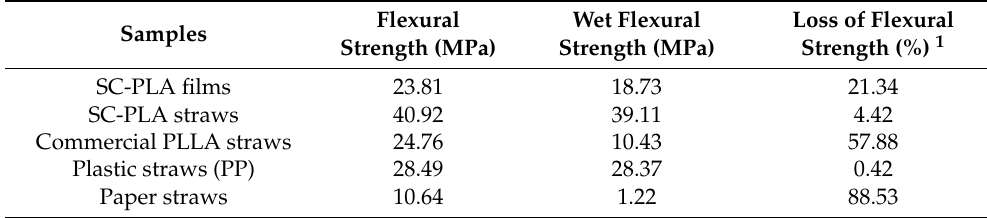
Table 3. Comparison of average flexural strength and loss of flexural strength of straws exposed to 100 ◦ C hot water for 10